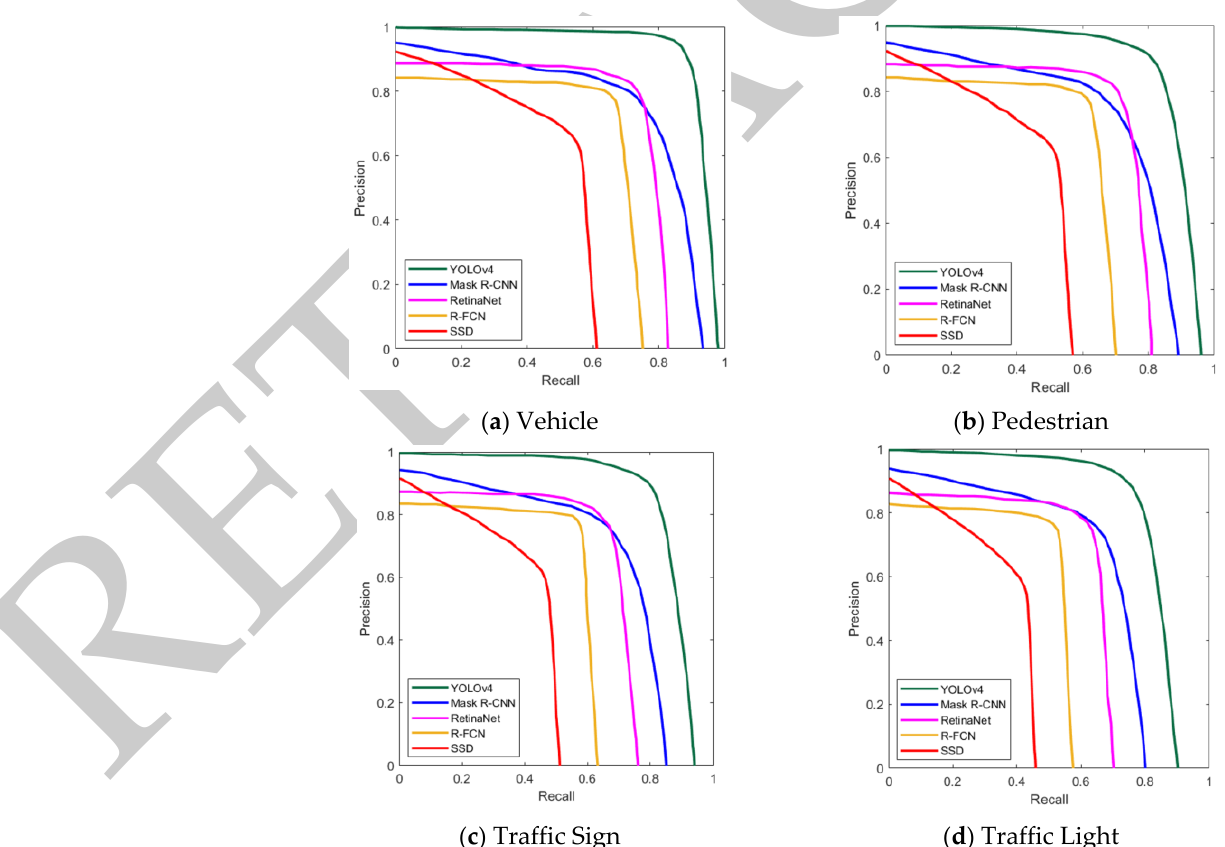
Figure 10. Precision-Recall (PR) curves of object detection models without occlusion and truncation on BDD100K dataset.